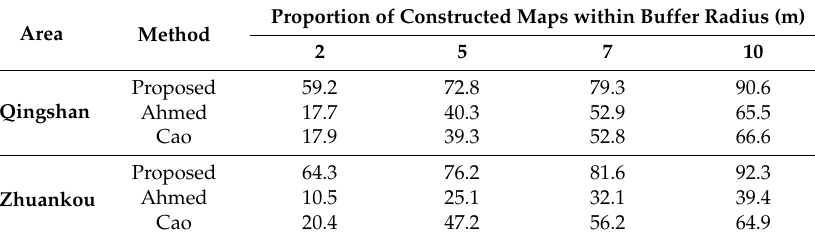
Table 1. Proportion of constructed maps within different buffers.